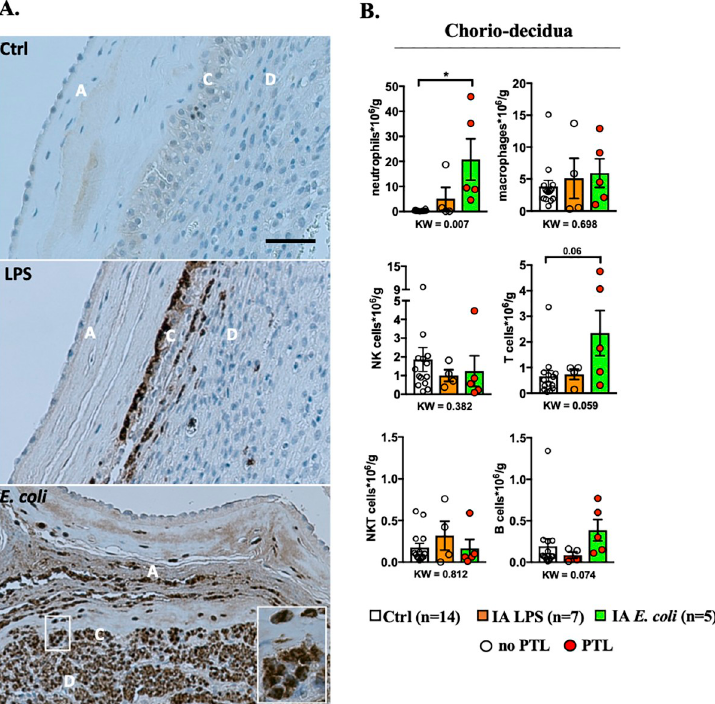
Fig 1. Increased neutrophil infiltration in chorio-decidua upon IA LPS or E . coli exposure. (A) One representative MPO staining of 4/group showing neutrophil infiltration in fetal membranes after LPS or live E . coli exposure but